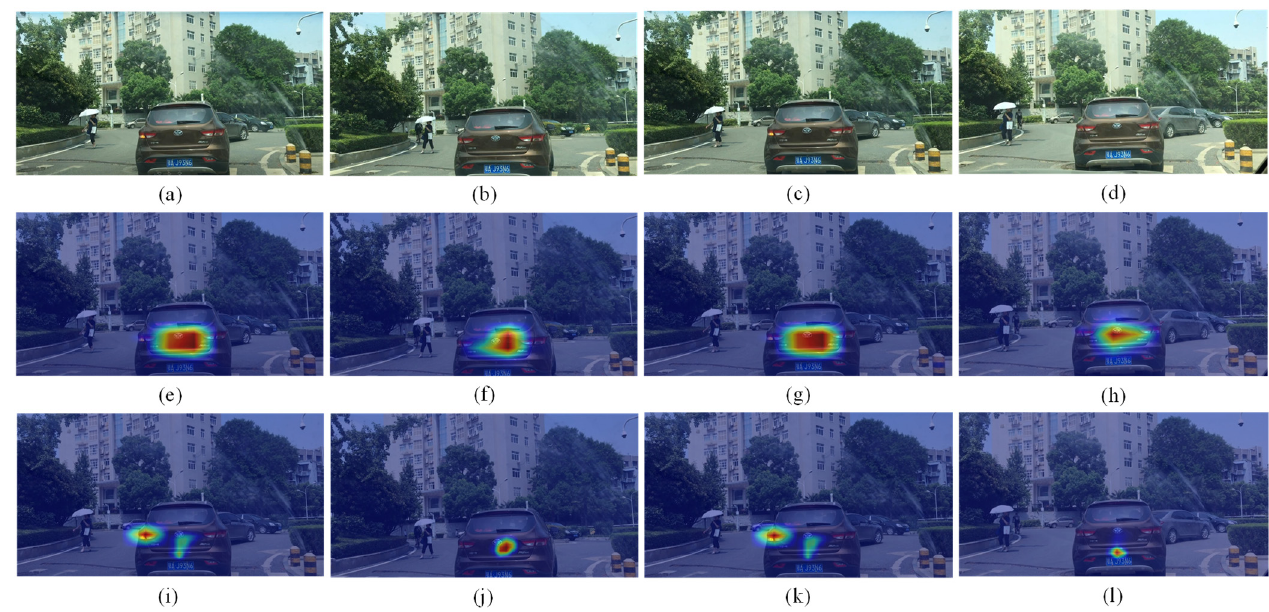
Figure 7. Visualization of interest regions for the baseline and the proposed method. ( a – d ) four consecutive pictures of left-turn signals from the preceding vehicle. ( e – h ) the interest regions of the baseline. ( i – l ) the interest regions of the proposed method.